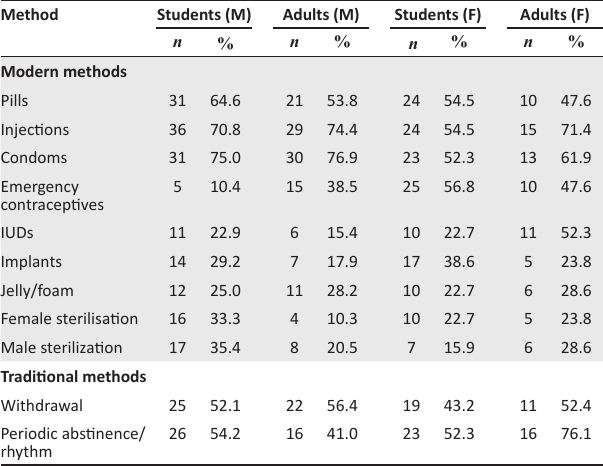
TABLE 1: Percentage indicating knowledge of contraceptive methods by age and